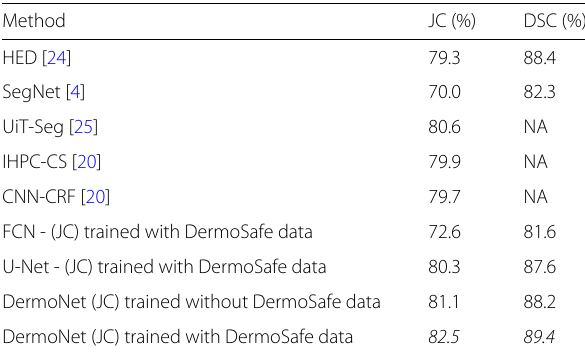
Table 4 Performance comparison between the proposed segmentation and other state-of-the-art methods on ISBI 2016 challenge test set